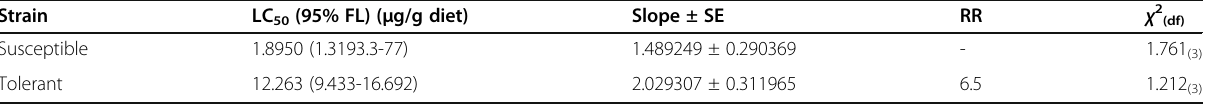
Table 4 Susceptibility of susceptible and Bt Cry1C — tolerant strains (10th generation) of S. littoralis larvae